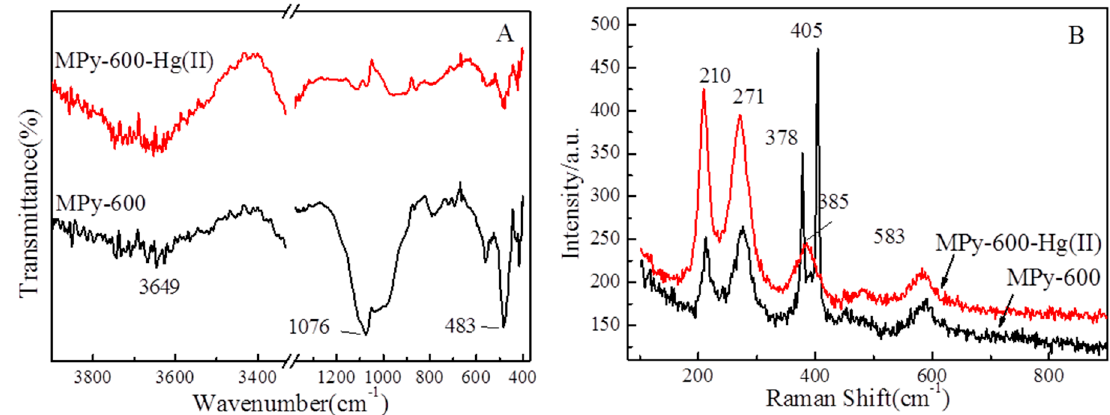
Figure 8. ( A ) The FTIR and ( B ) Raman spectra of MPy-600 and MPy-600 after Hg(II) adsorption.